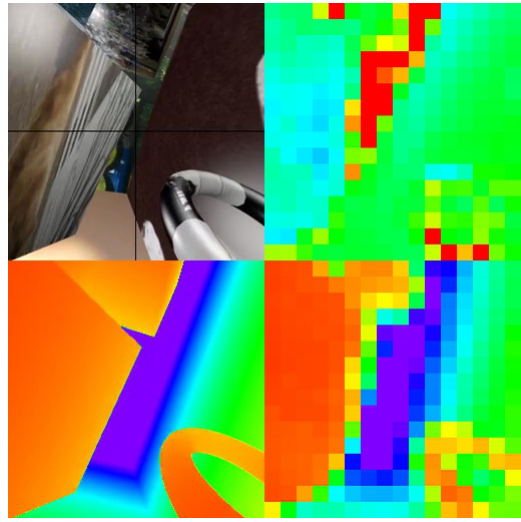
Figure 4. result for 64x64 images, upper-left: input (before being downscaled to 64x64), lower-left: Ground Truth depth, lower-right: our network output (16x16), upper-right: error (green is no error, red is over-estimated depth, blue is under-estimated) and disparity, such as FlowNetC or GC-Net (Kendall et al., 2017) among many others. The main point of this experimentation is to show that direct depth estimation can be beneficial regarding unknown translation. Like FlowNetS, we use a multi-scale crite- rion, with a L1 reconstruction error for each